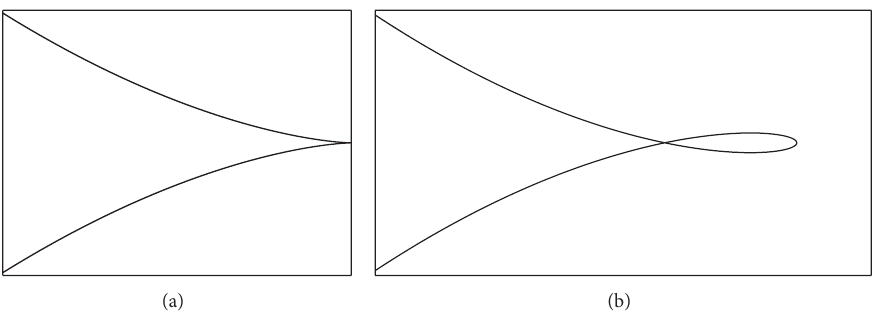
Figure2:Creationandextinction(inmirrormode)ofaseparatrixloopinthesaddle-centerbifurcationat 𝑡 ∗ = 𝑡